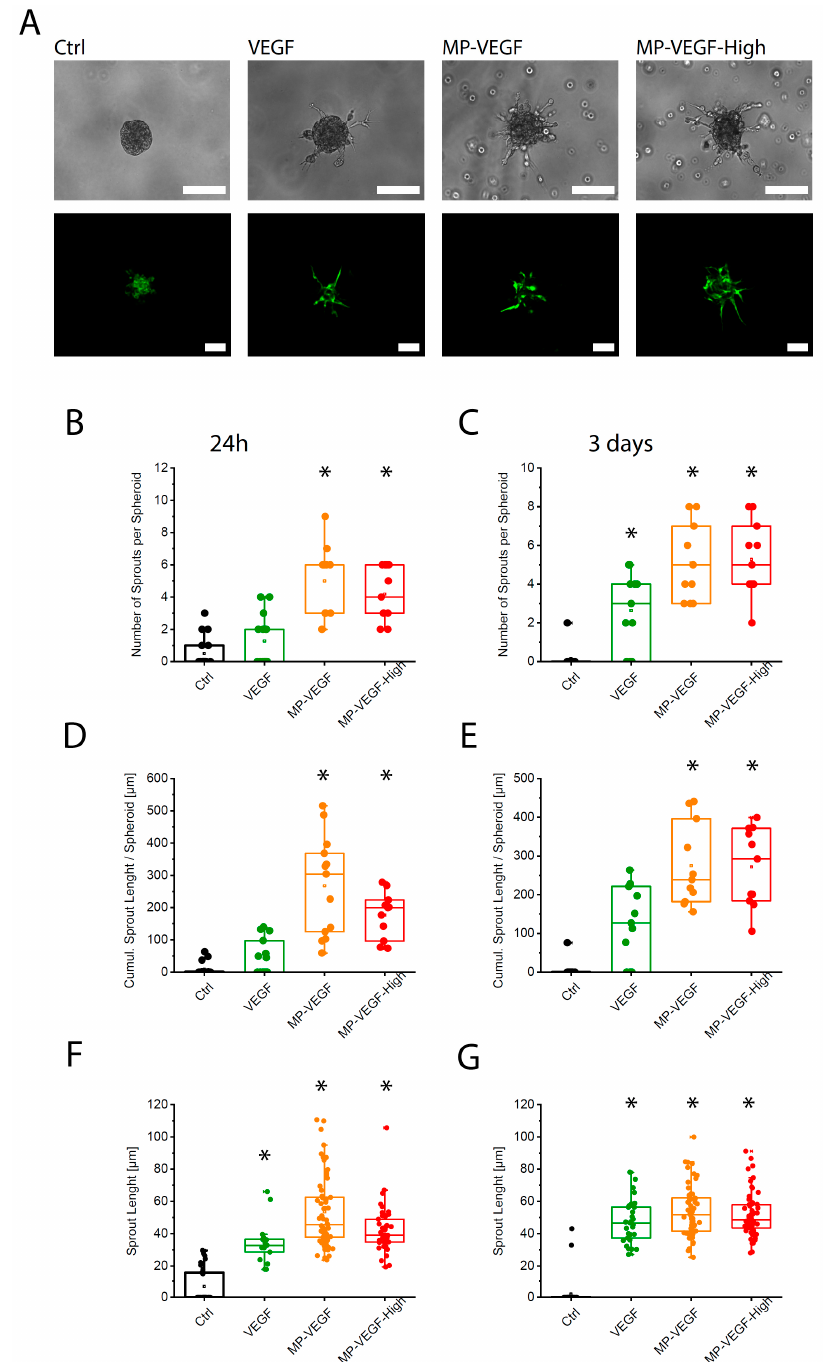
Figure 4. VEGF release accelerate spheroids sprouting in 3D. ( A ) The effect of microparticles releasing VEGF-A on endothelial cell sprouting from spheroids in 3D microenvironments. Morphology of endothelial cell sprouts in bright-field and fluorescence microscopy images, scale bar: 100 µm. Ctrl: HUVEC spheroids grown in EGM-2 medium, VEGF: HUVEC spheroids stimulated with 50 ng/mL VEGF-A, MP-VEGF: microparticles releasing VEGF-A (50 ng/mL initial loading), MP-VEGF-H: microparticles releasing high concentration of VEGF-A (100 ng/mL initial loading). Number of sprouts per spheroid after ( B ) 24 h and ( C ) 3 days. Cumulative sprout length after ( D ) 24 h and ( E ) 3 days. Length of individual sprouts after ( F ) 24 h and ( G ) 3 days. * indicates significant difference comparing to Ctrl ( p < 0.001) evaluated by one-way ANOVA.